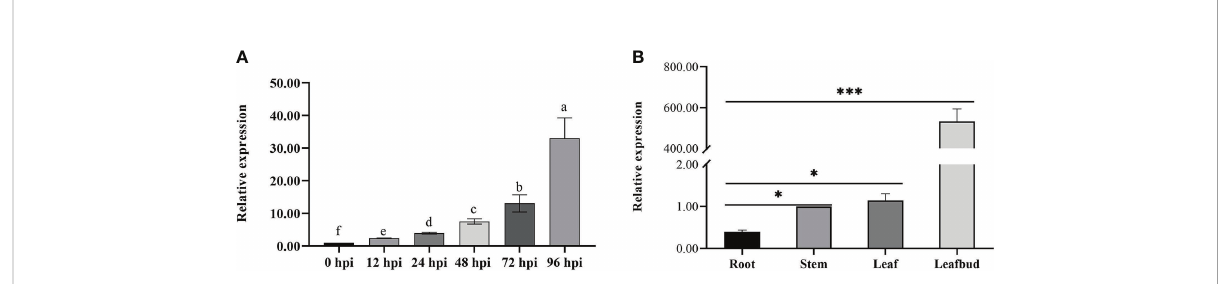
FIGURE 3 (A) Relative expression analysis of CoDF R at different time points during C fructicola infection (B) Tissue-speci fi c expression analysis of CoDFR in disease-resistant line. Error bars represent ± SD from three biological repeats. "*" indicates signi fi cant difference from WT (p<0.05), "***" indicates signi fi cant difference from WT